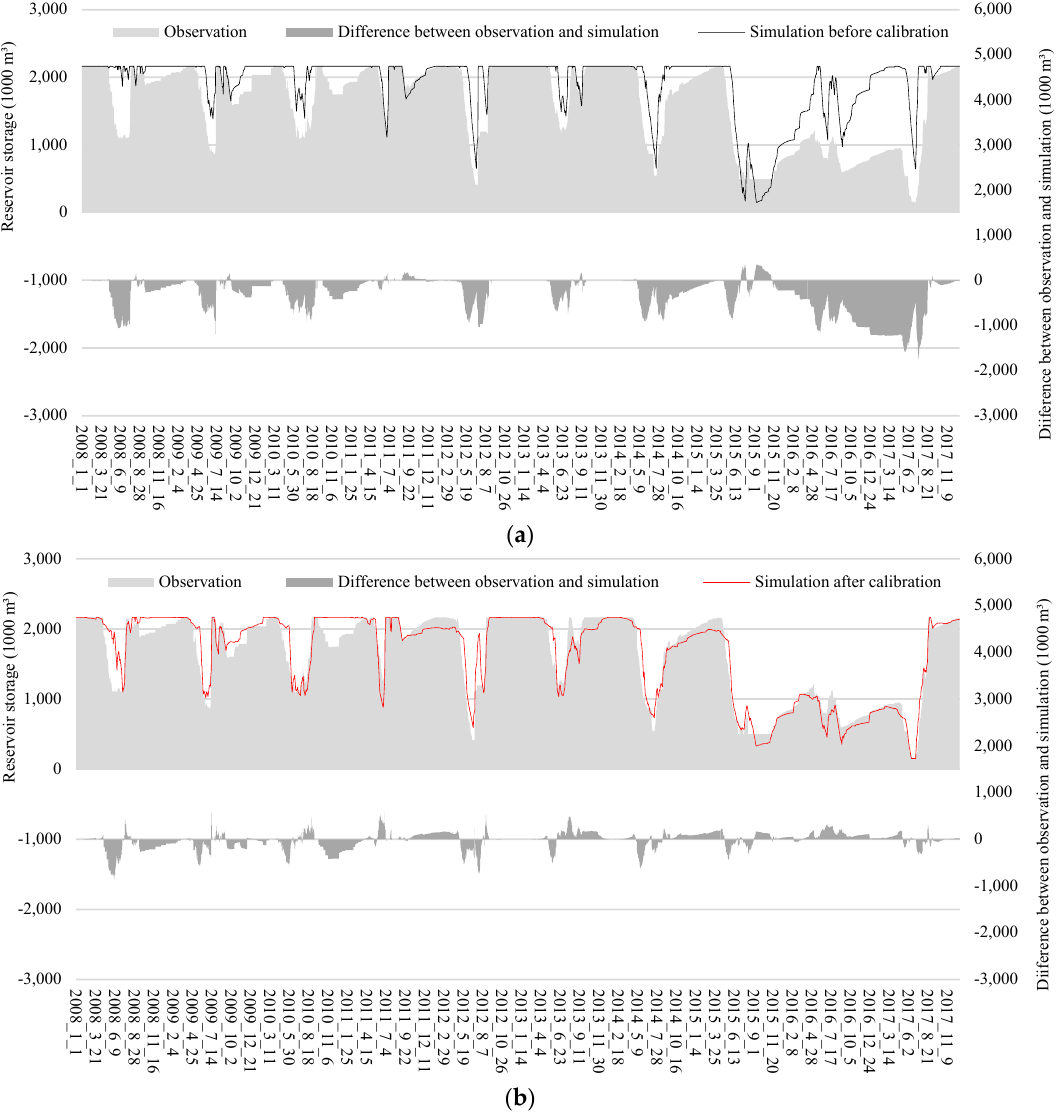
Figure 4. Simulation of water storage capacity of Kicheon reservoir before and after calibration using RCFs. ( a ) Before calibration (Kicheon reservoir); ( b ) after calibration (Kicheon reservoir).